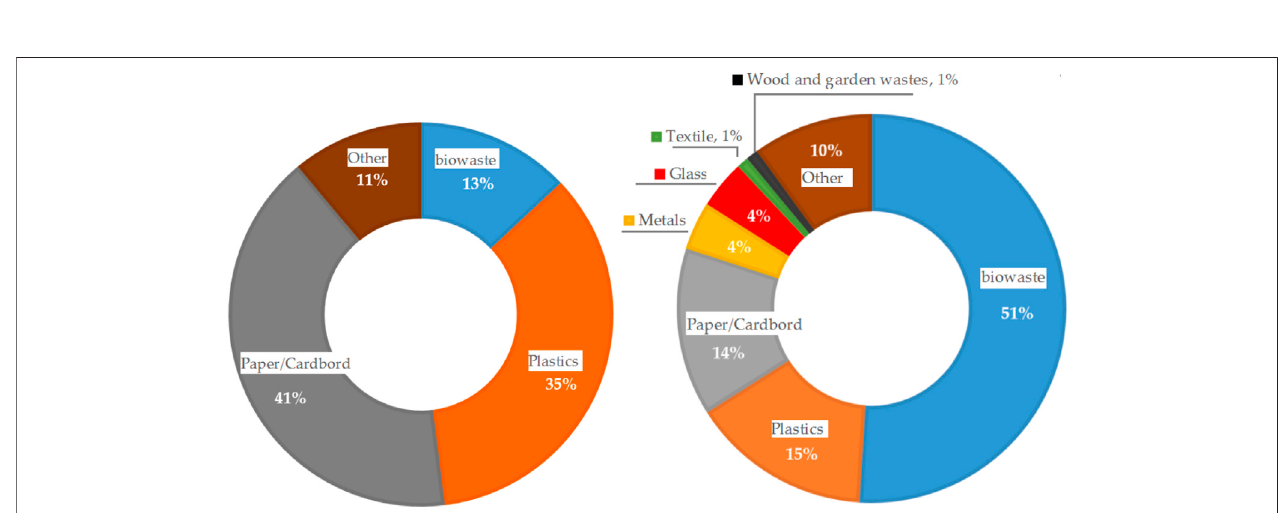
FIGURE 4 | Comparison between GJU (left) and municipal (right) waste composition.